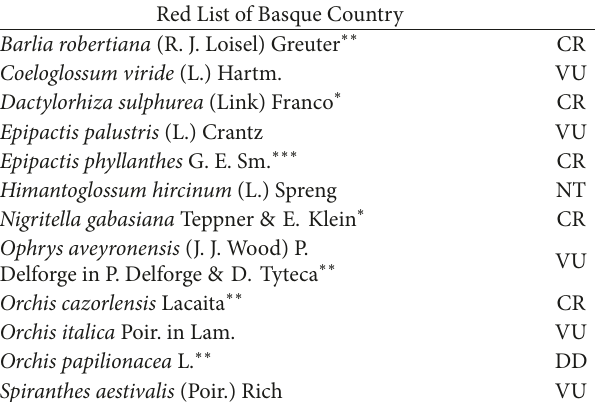
Table 8: Species included in the Red List of Basque Country [93].